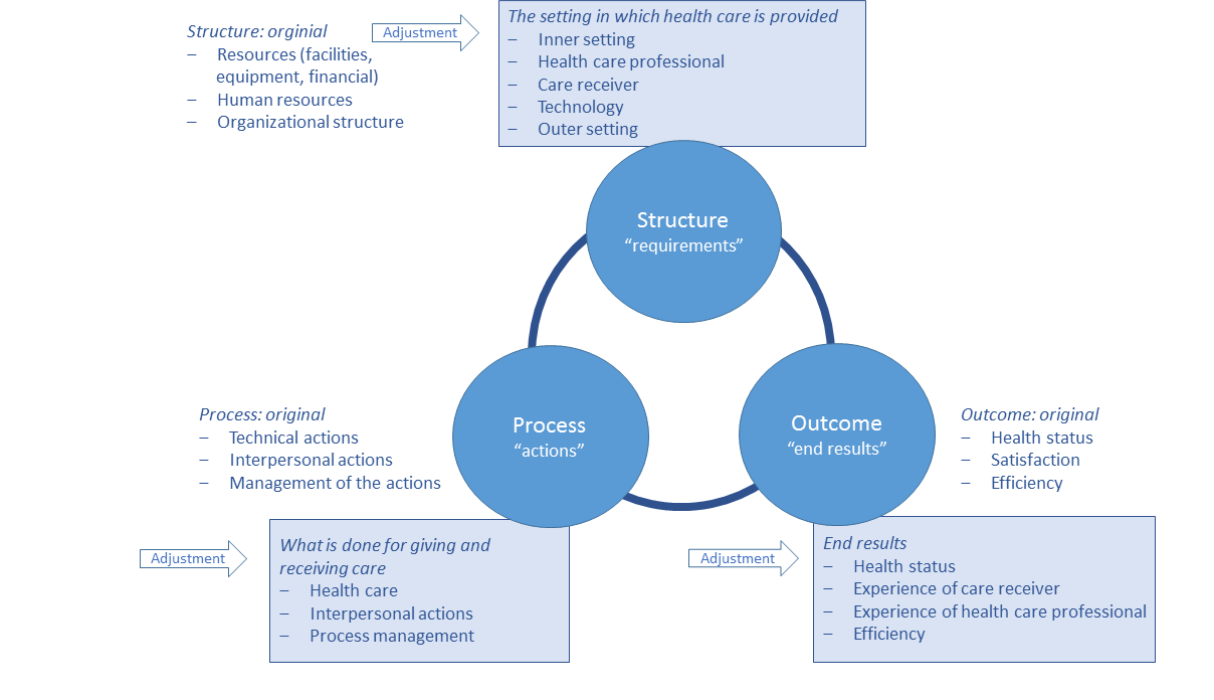
Figure 3. Adjustment to the themes of the Structure-Process-Outcome framework, considering eHealth